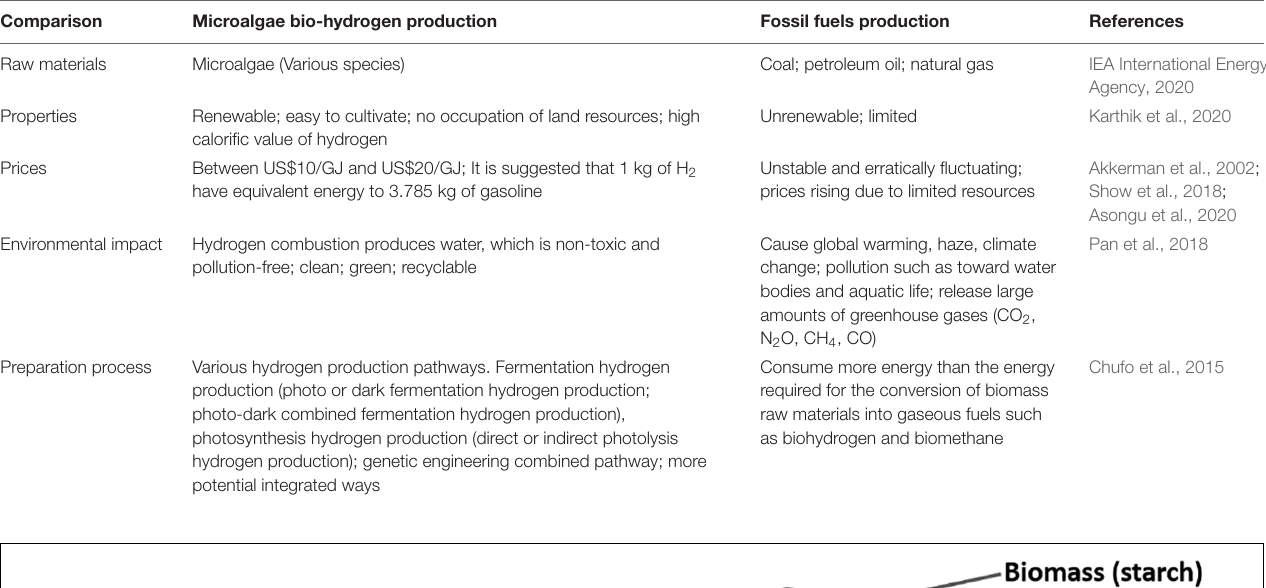
TABLE 1 | Comparison between microalgae biohydrogen process and conventional fossil fuels.